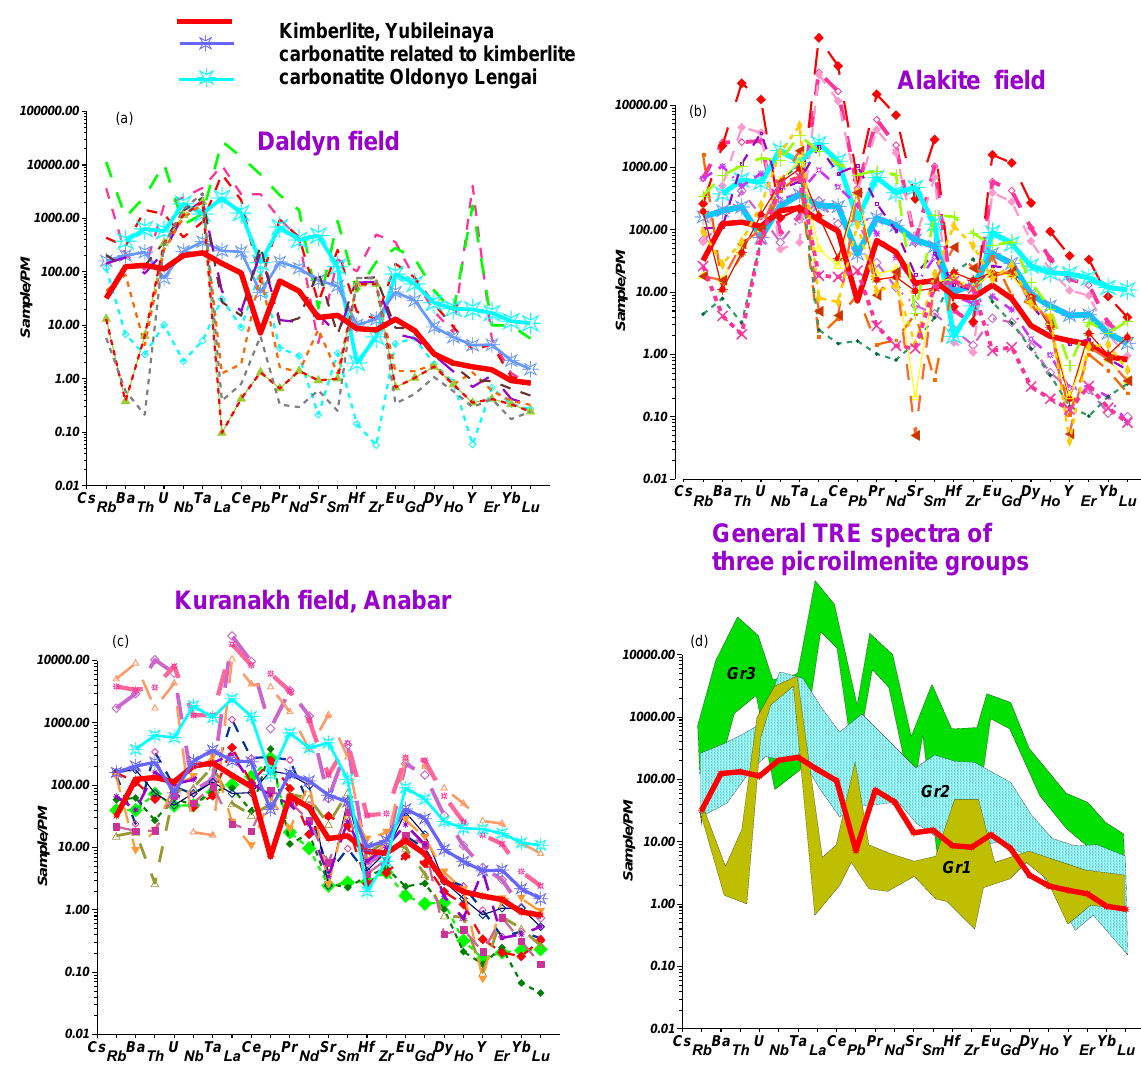
Figure 14. Trace element patterns for parental melts for the ilmenites from the different regions in Yakutia: (a) Daldyn, (b) Alakit, (c) Kuranakh field, Anabar region and (d) typical trace element patterns for three ilmenite groups. Signs: 1. Kimberlite from the Yubileynaya pipe (Kostrovitsky et al., 2007); 2. Carbonatite associated with kimberlite 3. Carbonatite from Oldoinyo Lengai (Bell and Simonetti, 1996; Bizimis et al.,